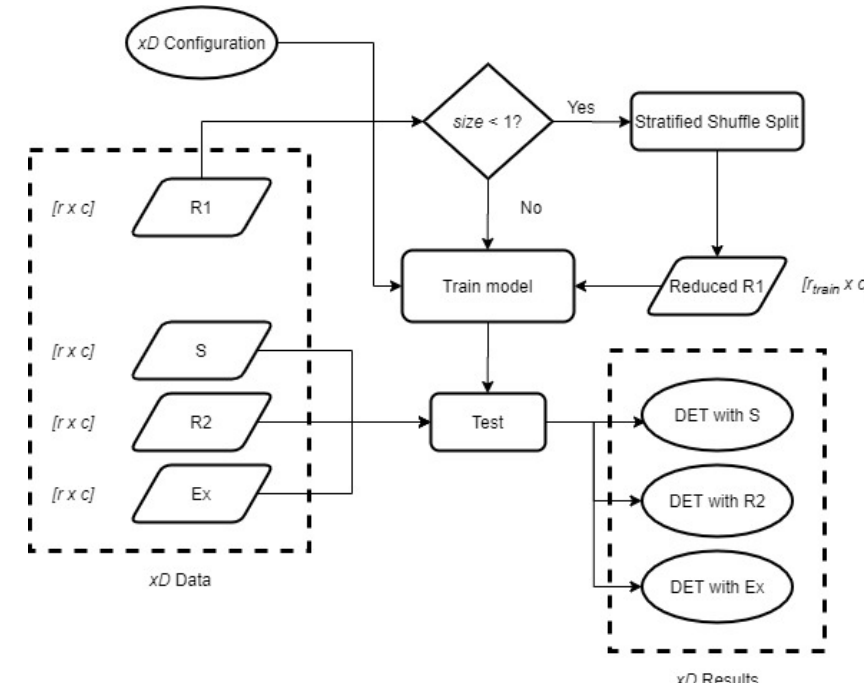
Figure 6. Performance evaluation scheme for different test sets when using R1 with xD signals in